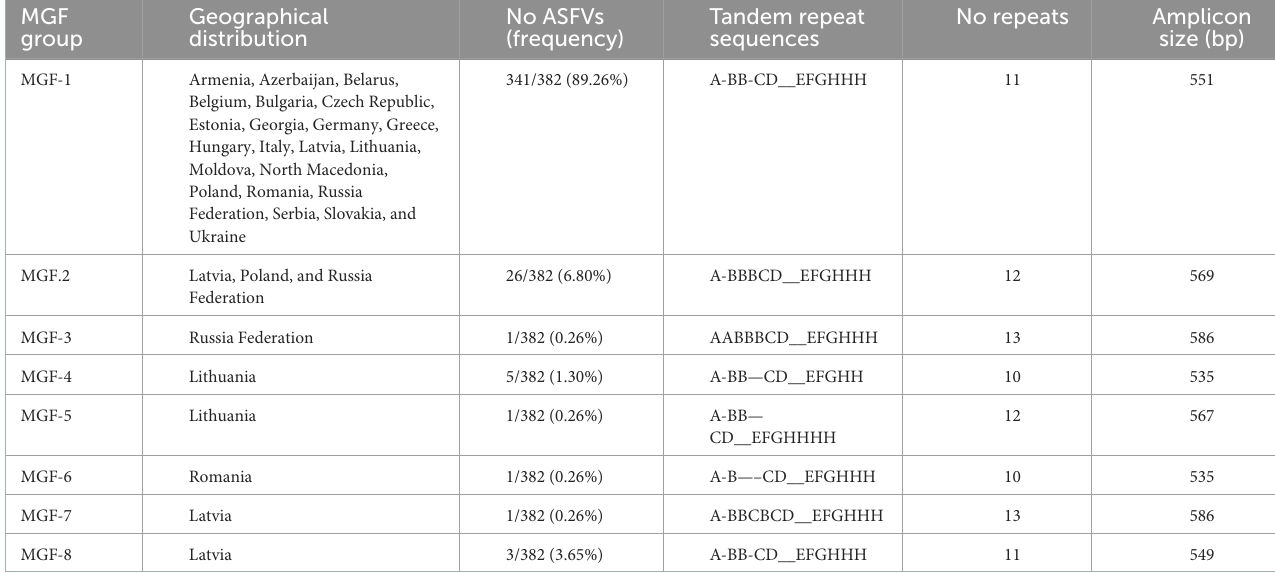
TABLE 3 Groups based on the analysis of the TRS in the IGR between the 9R / 10R genes of the multigene family (MGF) 505. Dashes indicate gaps introduced to enable similarities between sequences to be more easily visualized. MGF Geographical group